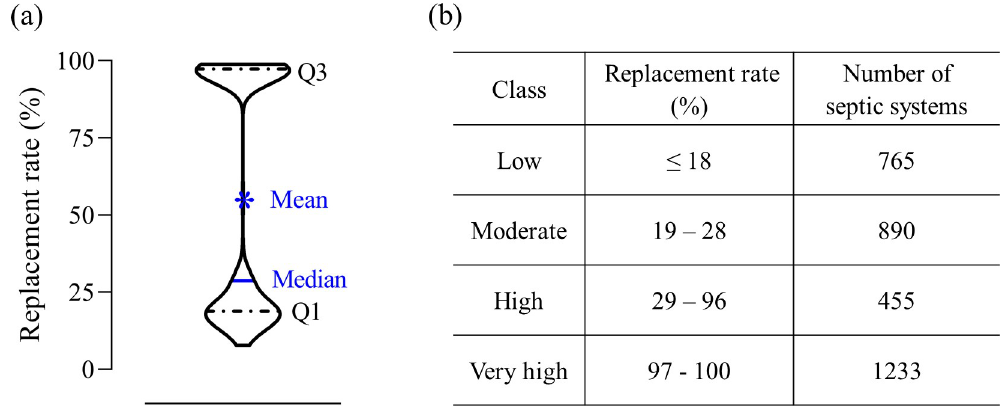
Fig 9. Distribution of septic systems replacement rate (%) (a), and class, calculated probability replacement rate (%), and the number of septic systems in each class (b) in the southern part of Bryan County, GA. Q1 represents the first quartile, and Q3 represents the third